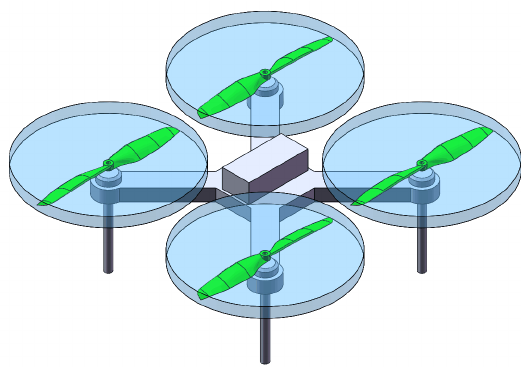
Figure 5. Rotation calculation domain.